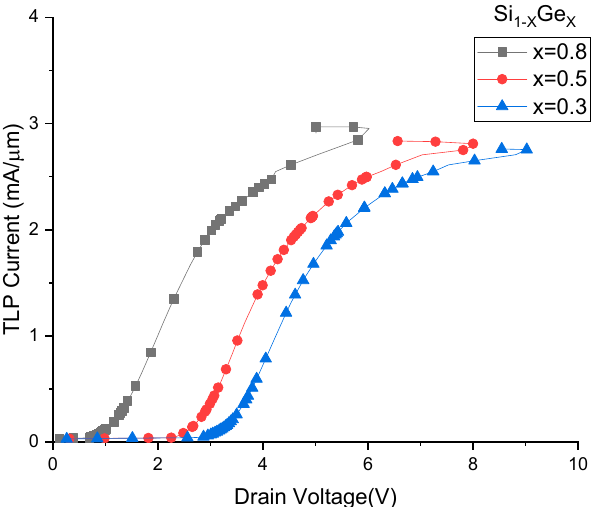
Figure 11. TLP I-V curves of SiGe S/D PNN TFET with different Ge mole Figure 11. TLP I ‐ V curves of SiGe S/D PNN TFET with different Ge mole fractions.